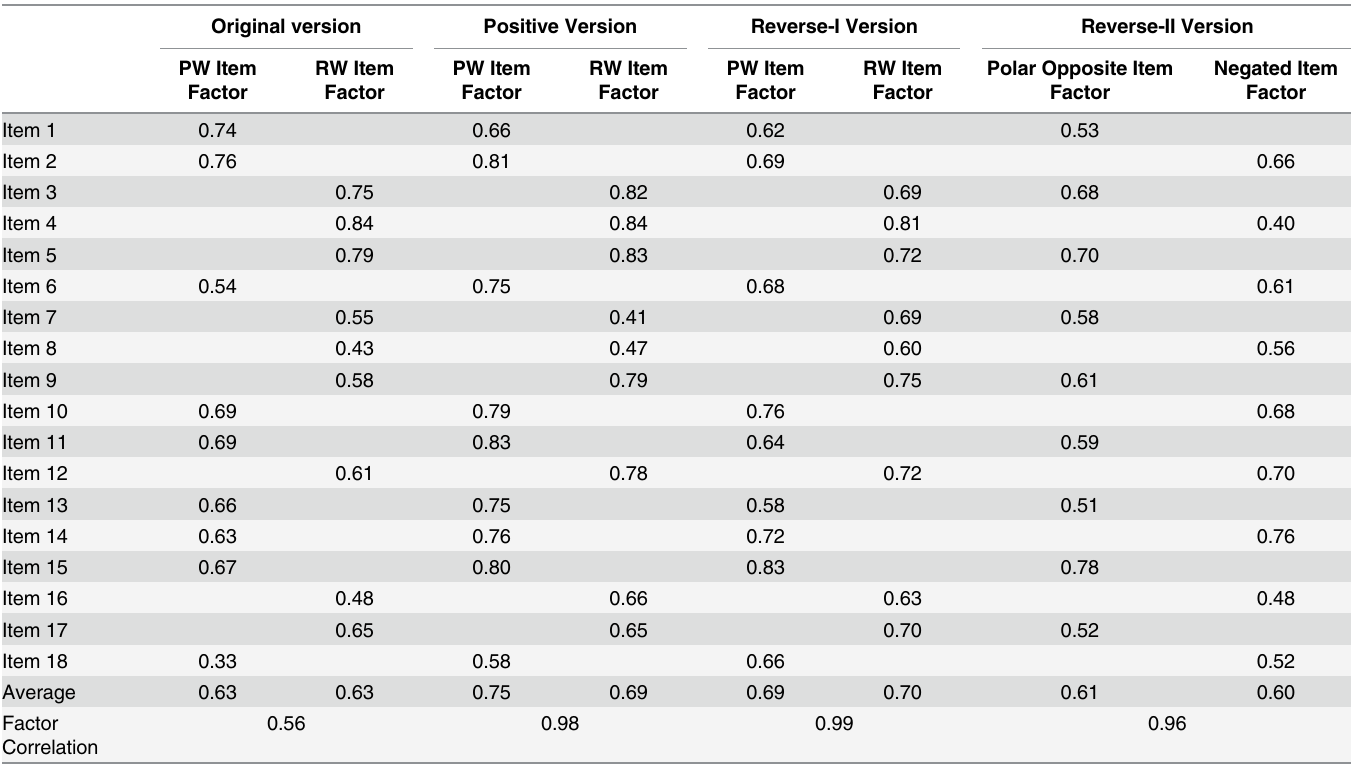
Table 5. Standardized Factor Loadings of Model 2 for the Four Scale